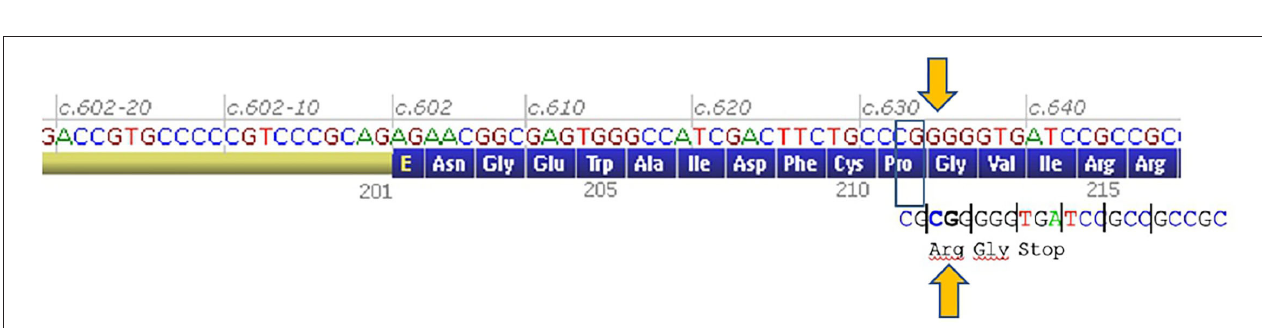
FIGURE 3 | Genetics. A 2-bp shift of a reading frame from Codon 212 and premature stop codon at codon 214 of CHRNE gene (an image of this part of mRNA was taken from Alamut Visual software, Interactive Biosoftware Sophia